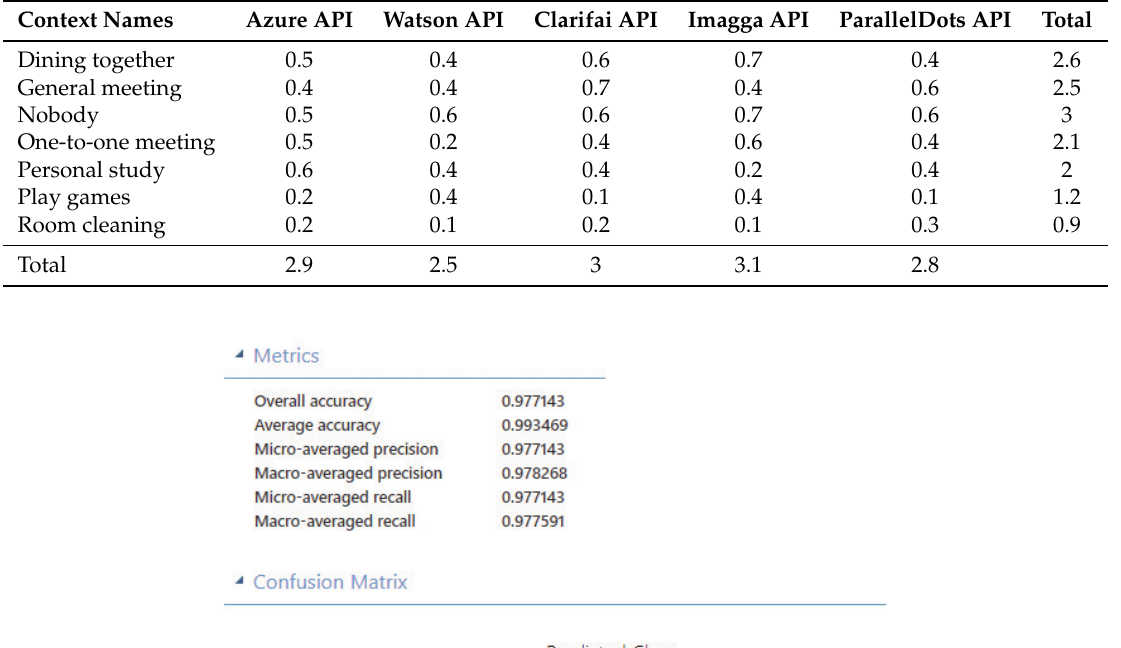
Table 1. The maximum value in each row of the capability evaluation results of each API from Figure 4.